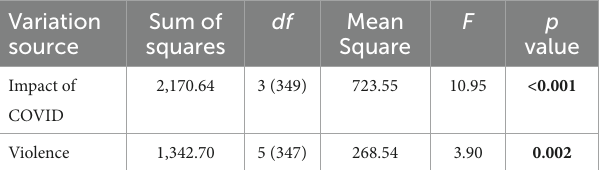
TABLE 9 Result of the analysis of variance (ANOVA), with self-criticism and difficulty concentrating when experiencing emotions as the dependent